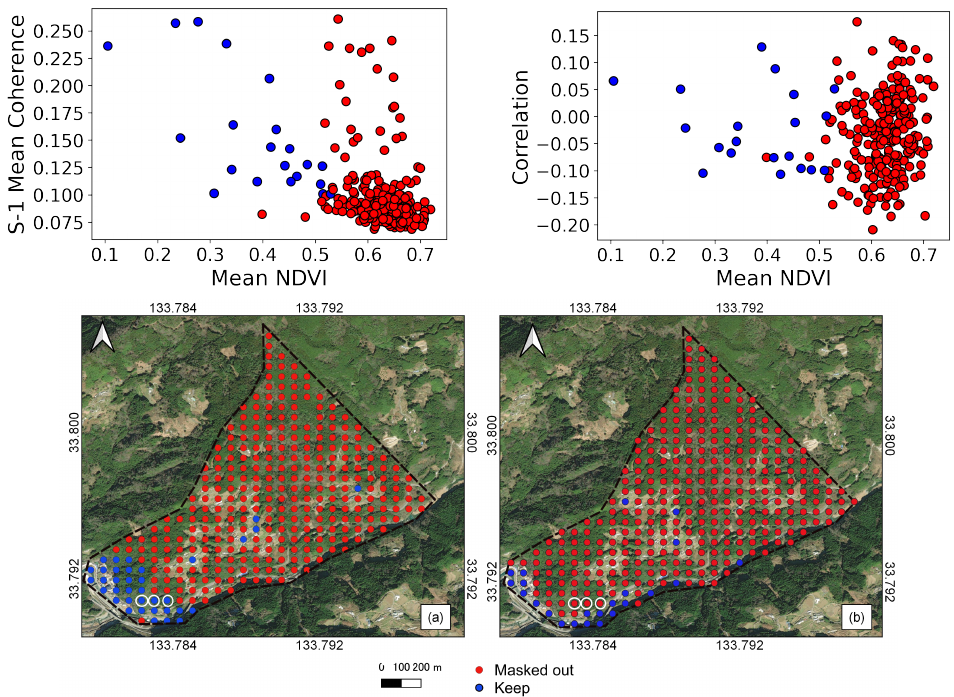
Figure 11. New samples classified according to the split of the RF model; blue points refer to pixels included in the analysis, while red points are masked out. The features were the mean NDVI and S-1 mean coherence ( a ), and the mean NDVI and the correlation between the S1 coherence and the NDVI time series ( b ). Georeferencing of pixels took place before and after the application of the RF mask, where white-highlighted pixels represent forest regions; these pixels were excluded from the CB-SBAS analysis and show no sign of displacement in the ground survey observations.